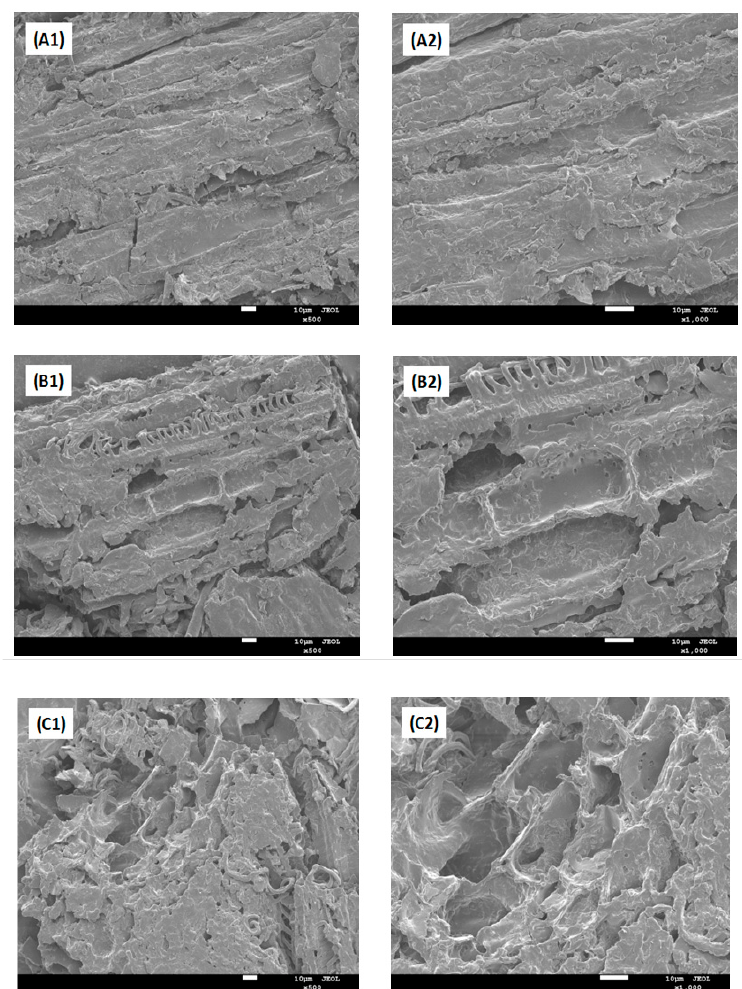
Figure 2. Scanning electron micrographs (SEM) of the samples; ( A1 ) control-ground sample × 500; ( A2 ) control-ground sample × 1000; ( B1 ) microwave-assisted extracted (MAE) sample in min × 500; ( B2 ) MAE sample in min × 1000; ( C1 ) MAE sample in high × 500; ( C2 ) MAE sample in high × 1000.